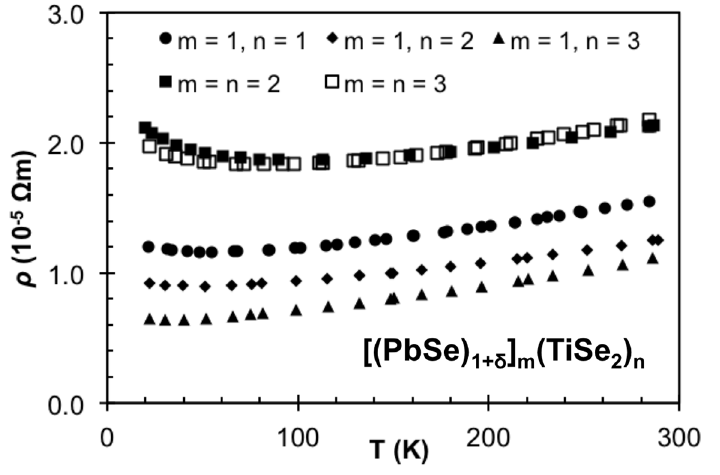
Figure 15. Temperature dependent in-plane resistivity for compounds from set A (black text in Table